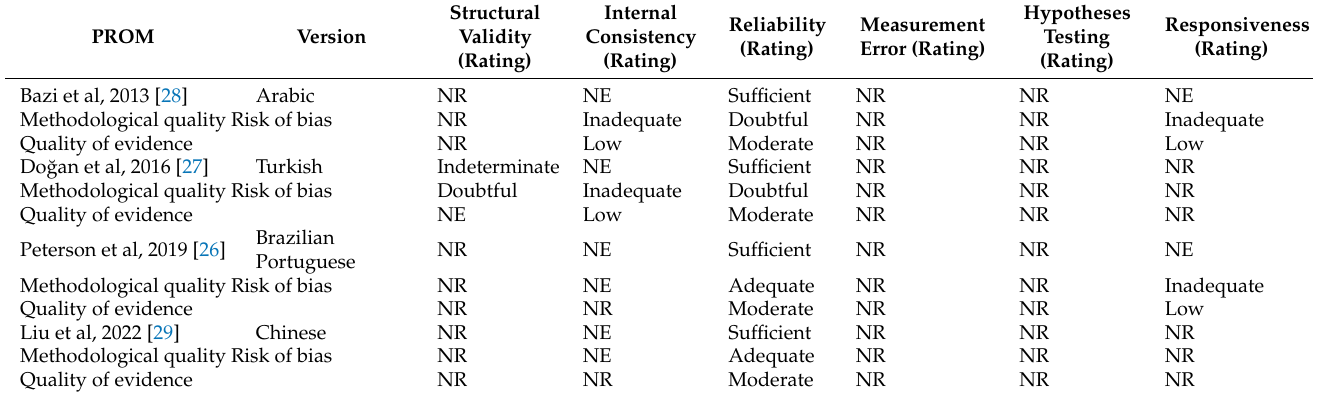
Table 3. Analysis of the rating of the psychometric properties, methodological quality and quality of